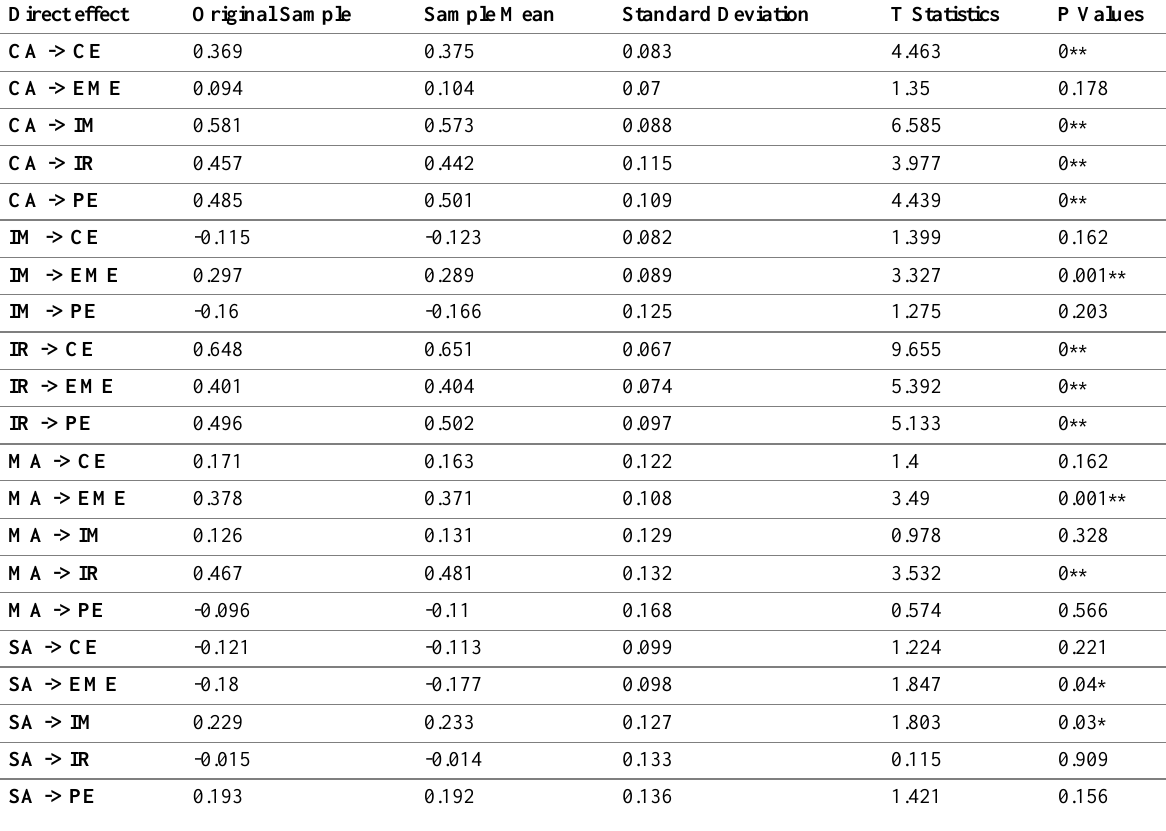
Table 6: Path coefficients